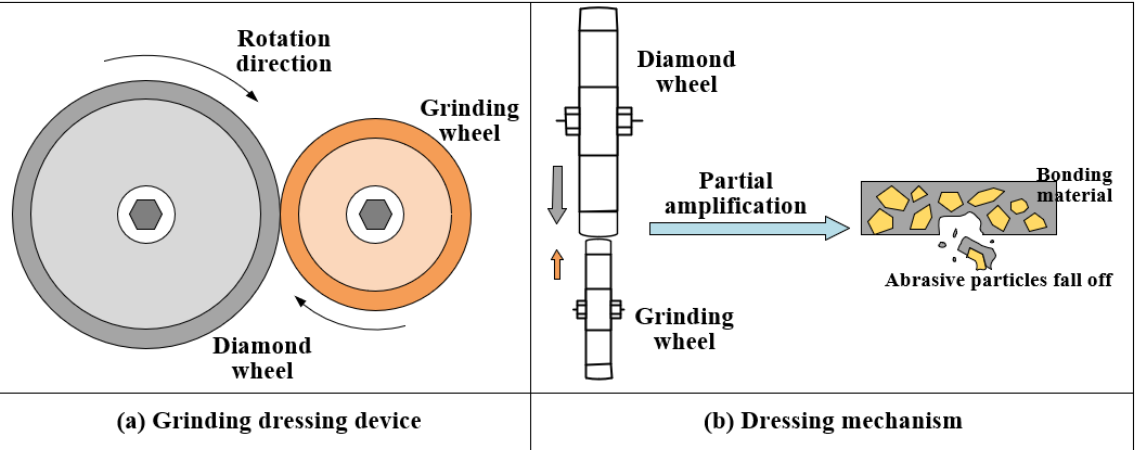
Figure 6. Schematic diagram of grinding method dressing.